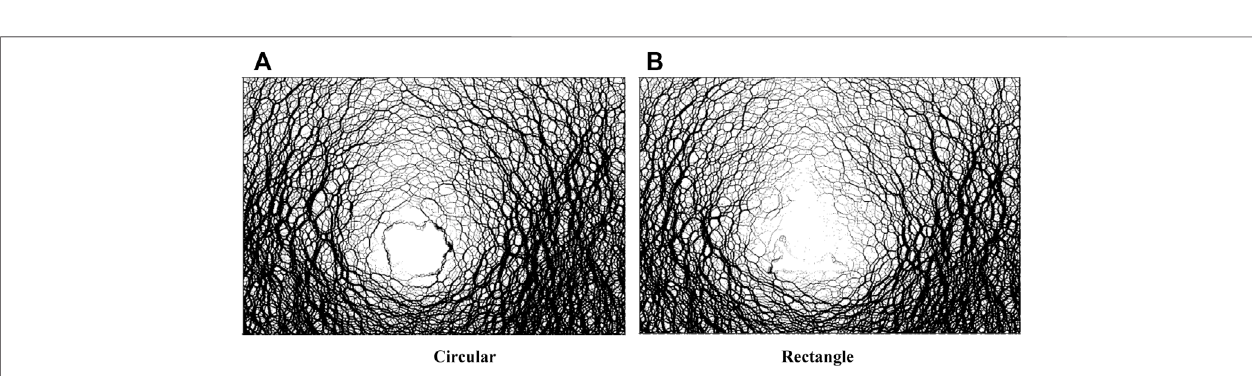
FIGURE 5 | Force chain patterns of circular and rectangular tunnels after earthquake. (A) Circular. (B)